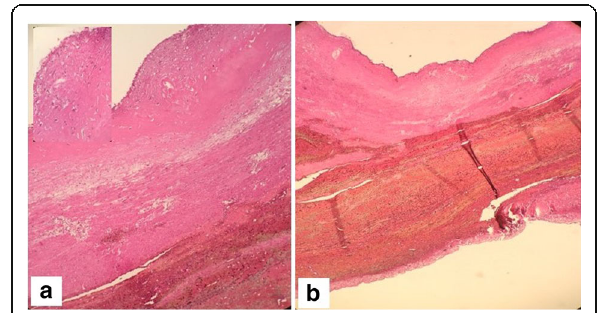
Fig. 5 a Photomicrographs of the coronary arterial wall showing medial cystic degeneration (10× magnification). No evidence of vasculitis was noted. Inset shows intima with atheromatous plaques (20× magnification). b Photomicrograph of the coronary arterial wall